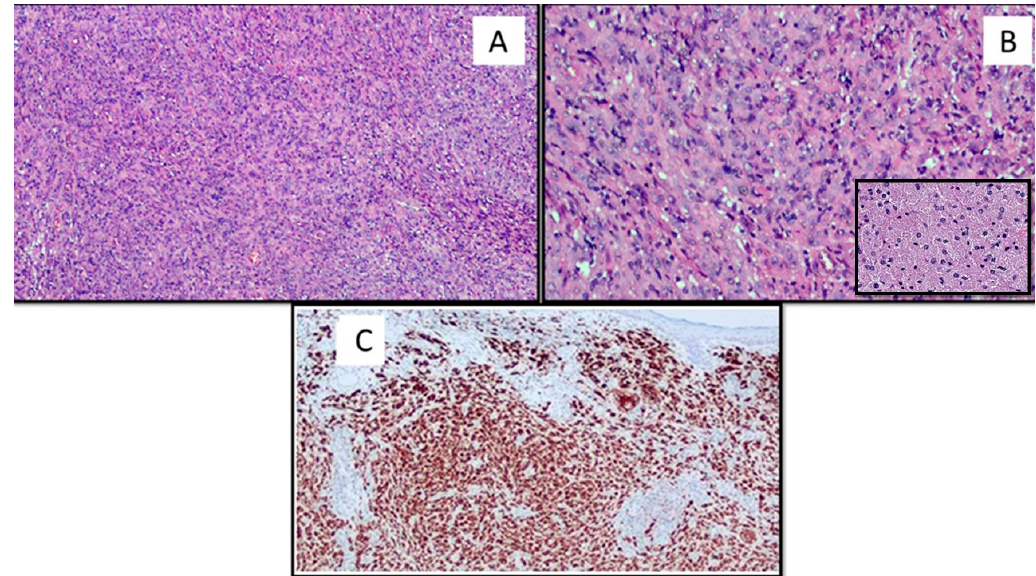
Figure 2. ( A ) The lesion was composed of a variable admixture of fibroblast-like cells and histiocytes that showed in more than 85% a large eosinophilic cytoplasm filled of granules or microvacuoles (hematoxylin and eosin, original magnification 40×). ( B ) Cytological details of the lesion with granular cytoplasm (original magnification 60×). Box: Histological details of the granular cytoplasm of the GCD constituent cells (original magnification 60×). ( C ) The neoplastic cells were strongly immunoreactive for CD68 (original magnification 40×).